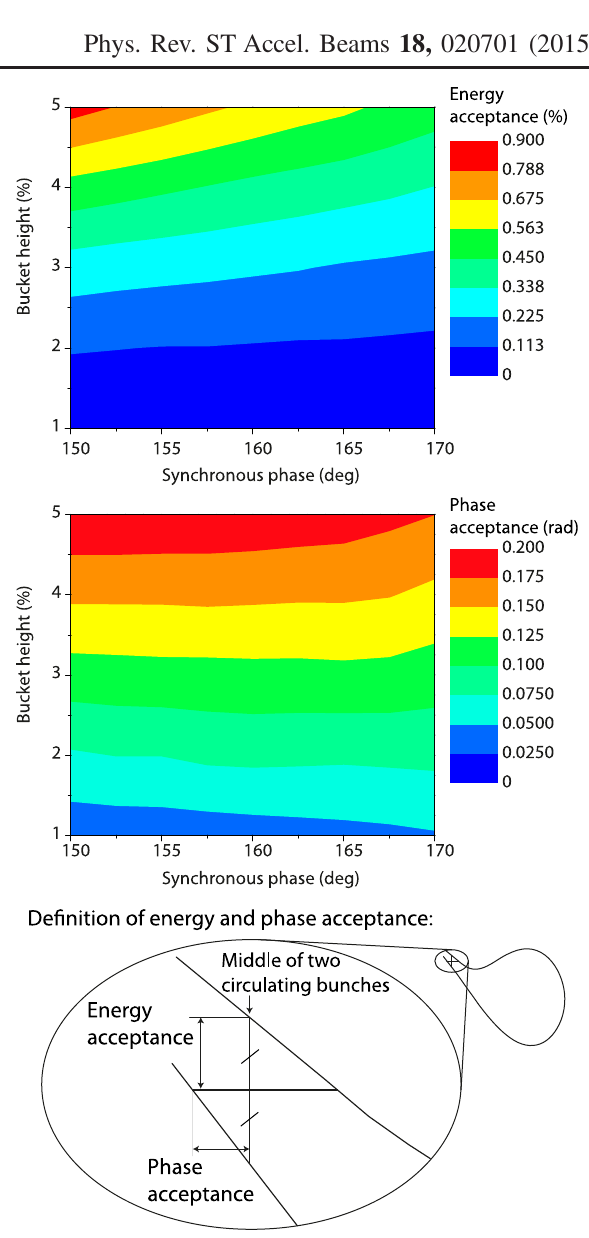
FIG. 10. Energy (top plot) and phase (center plot) acceptance. They are defined as shown schematically at the